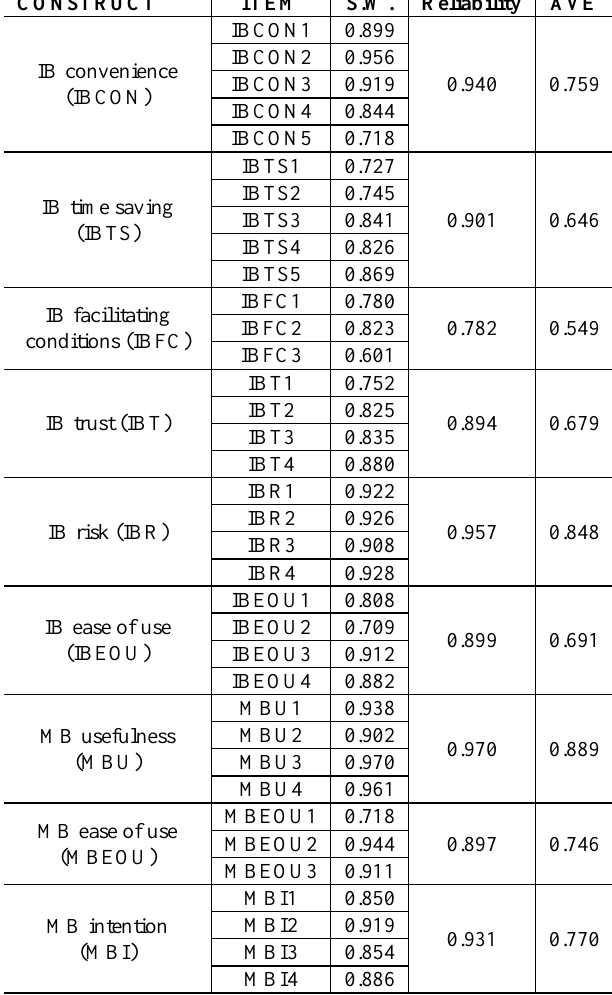
Table 2: Construct reliability and validity of the users